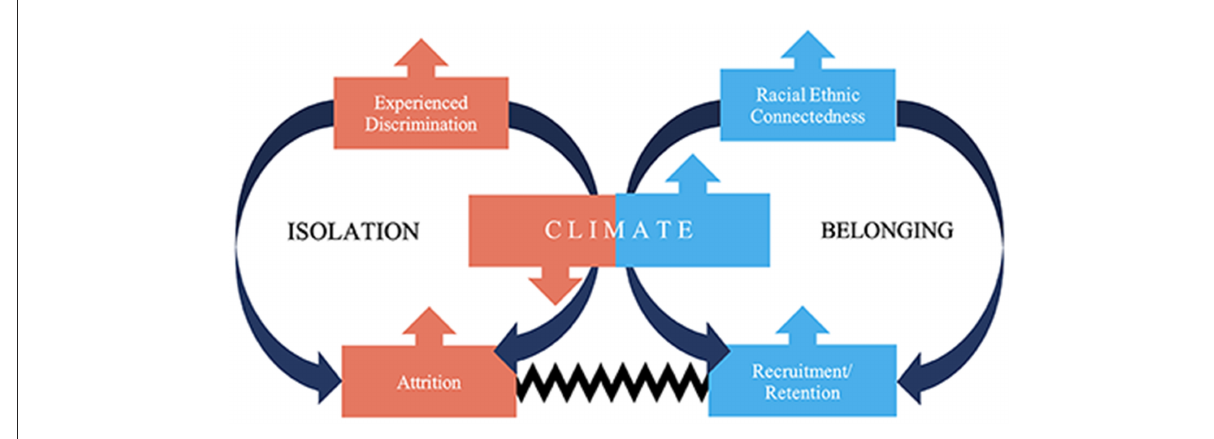
FIGURE1 Model depicting how the JAM council can address negative workplace climates while promoting recruitment and retention, connectedness, and